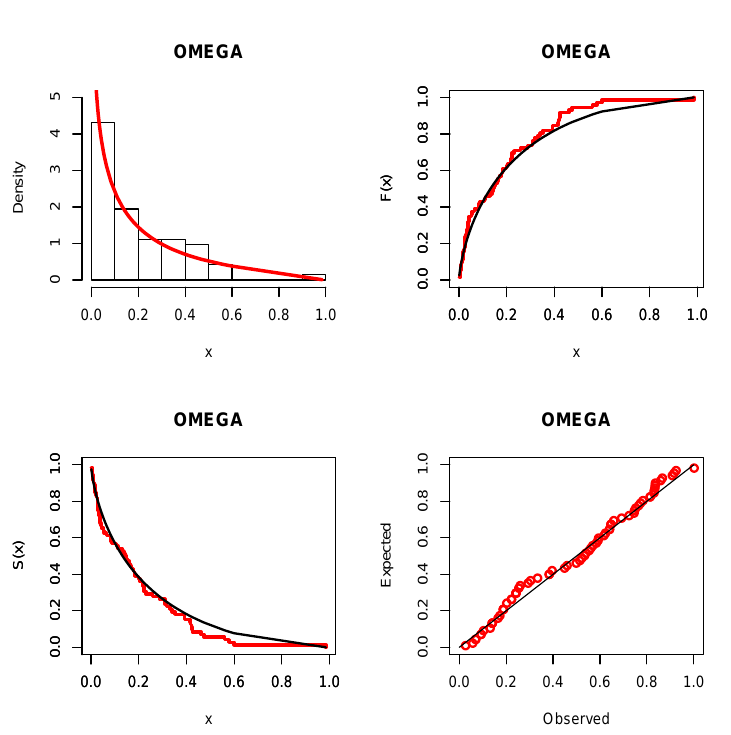
Figure 1. The fitted pdf , cdf , survival function, and probability–probability (PP) plots of the omega